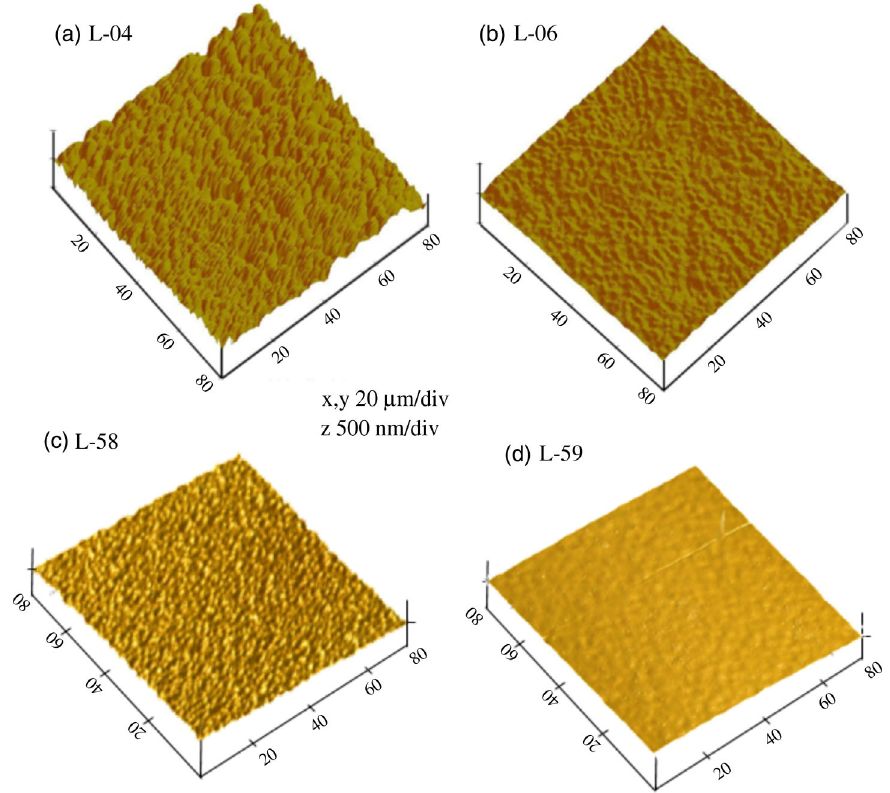
FIG. 4. AFM scan for samples (a) L-04, (b) L-06, (c) L-58 and (d) L-59 after 2N6 nitrogen doping and followed by BCP/EP. Samples L-04 and L-58 were subjected to BCP, whereas samples L-06 and L-59 were EP ’